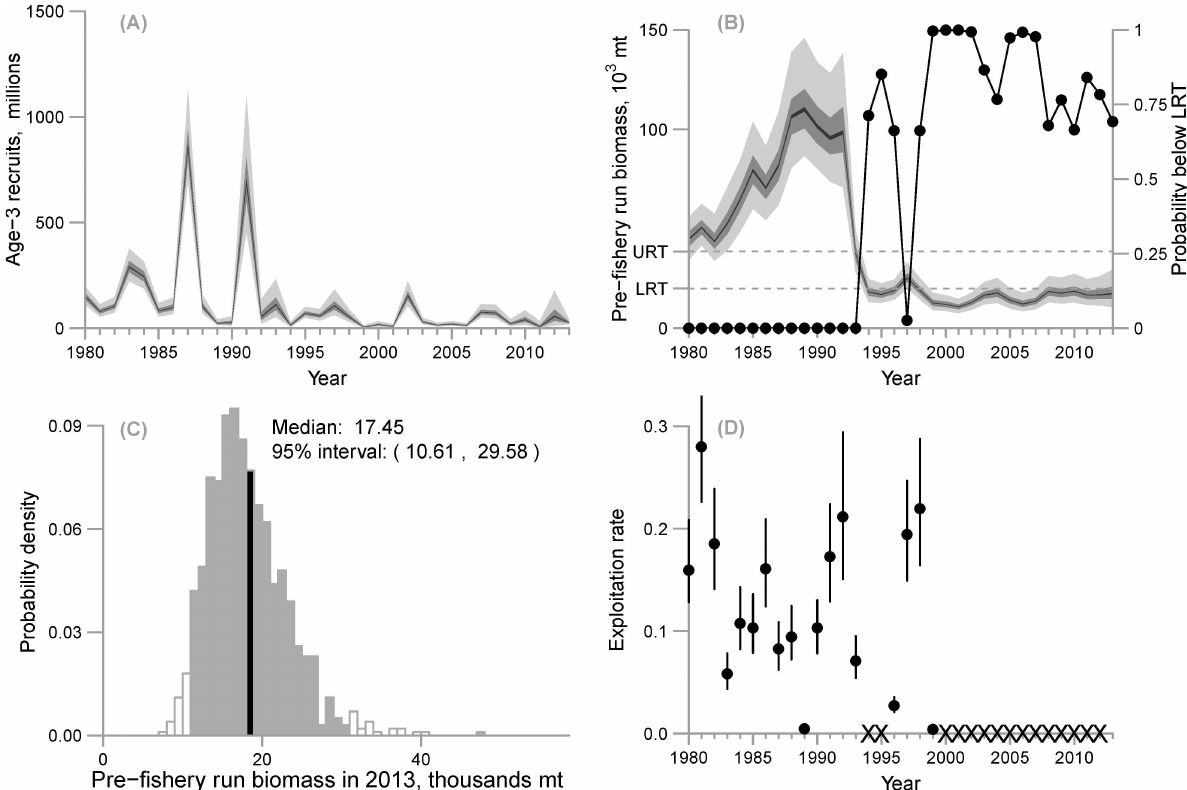
Fig 11. Results from the sensitivity analysis using the fixed value of 0.15 yr-1 for background natural mortality. See Fig 7 caption for explanation of panels,colors, and